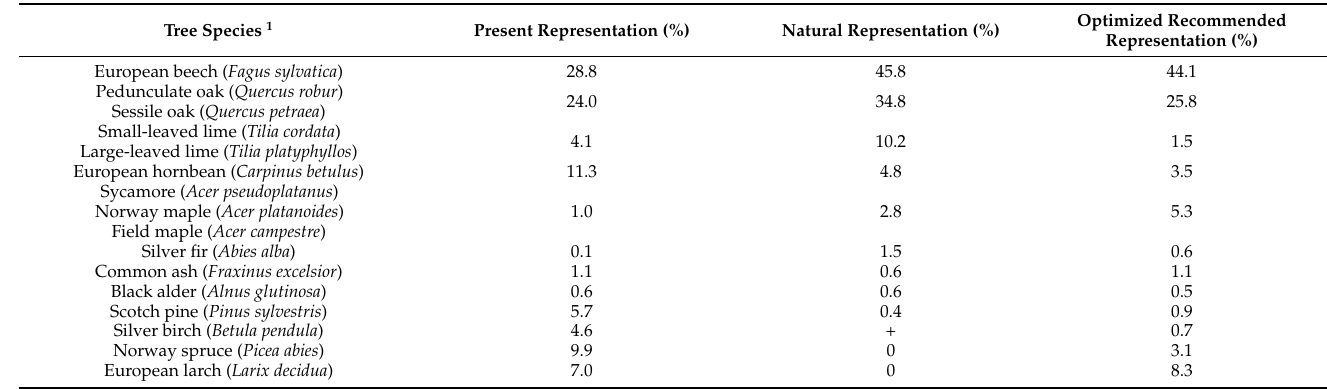
Table 1. Tree composition of forests in the Chˇriby hills within the natural forest region of the Stˇredomoravsk é Karpaty (Central Moravian Carpathians).